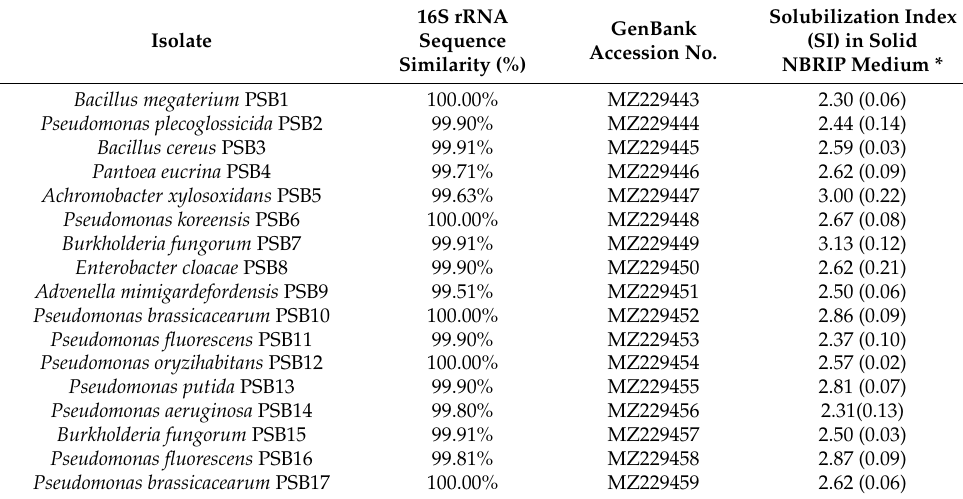
Table 1. Bacterial strains isolated from the barley plant rhizosphere and selected based on their higher- than-average phosphate solubilization index (SI) in solid BRIP medium and molecular identification by 16S rRNA